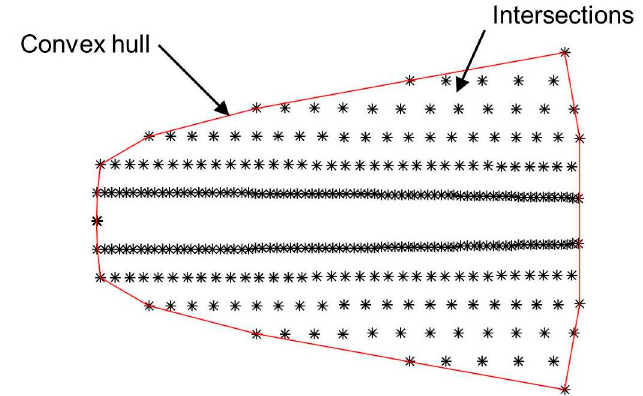
Figure 7. Generating the cut surface by locating the outer intersections.